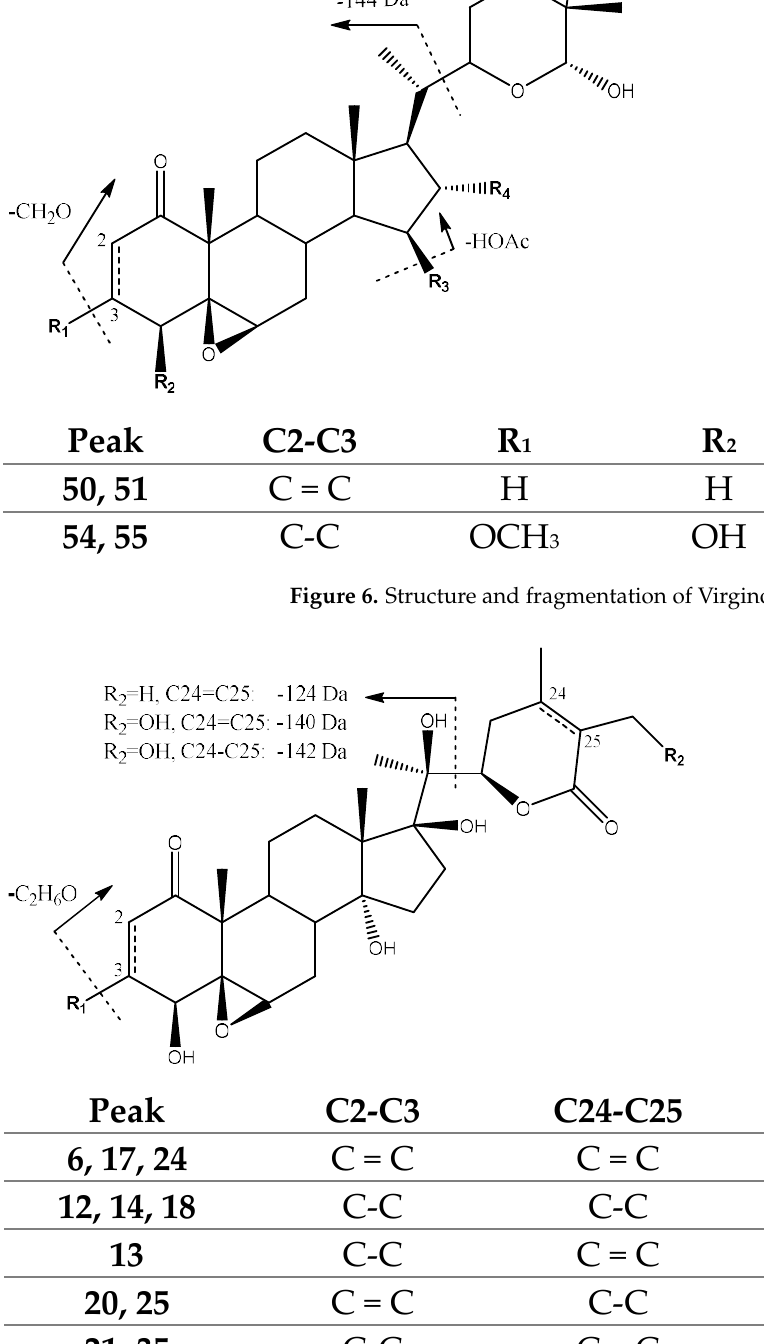
Figure 6. Structure and fragmentation of Virginol C and Peruvianolide E isomers.